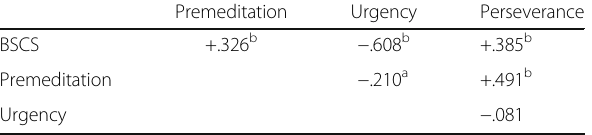
Table 5 Bivariate correlations between the impulsivity subscales of premeditation, urgency, perseverance, and the Tangney et